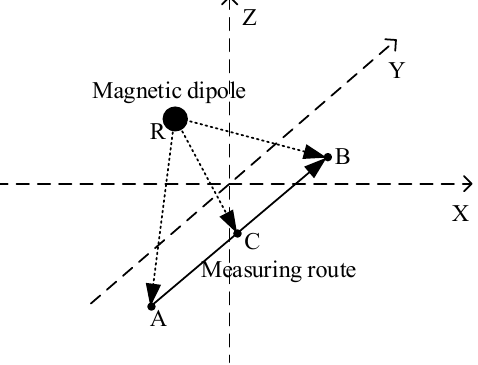
Figure 1. Schematic diagram of the localization method. The magnetic gradient tensors of points A and B are obtained via measurement. The magnetic gradient tensor of point C is obtained with the central difference method. The position of the magnetic dipole can be finally obtained with the tensor relationship of the magnetic gradient of three points and Equation (7), and it is not necessary to measure the three ‐ component value of the magnetic field. RA z ) represent the relative displacement vectors.